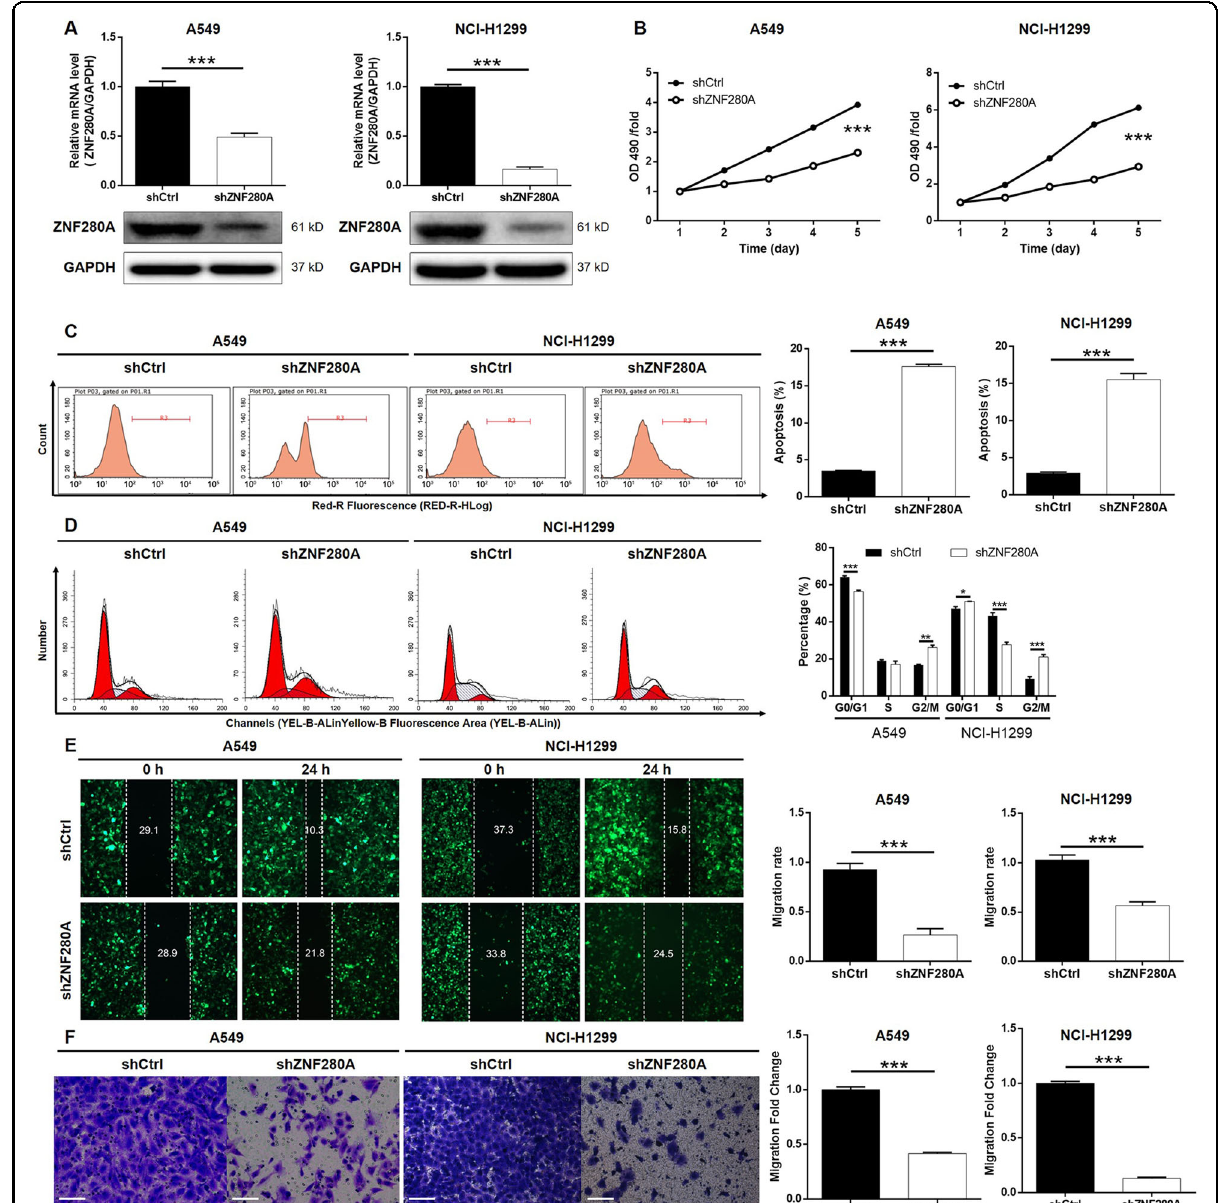
Fig. 2 ZNF280A knockdown inhibited LUAD development in vitro. A , B Cell models with or without ZNF280A knockdown were constructed by infecting shZNF280A or shCtrl. The knockdown ef fi ciency of ZNF280A in A549 and NCI-H1299 cells was assessed by qPCR and western blotting, respectively. B MTT assay was employed to show the effects of ZNF280A on cell proliferation of A549 and NCI-H1299 cells. C Flow cytometry was performed to detect cell apoptosis of A549 and NCI-H1299 cells with or without ZNF280A knockdown. D Cell cycle distribution was estimated in A549 and NCI-H1299 cells with or without ZNF280A knockdown. E , F The effects of ZNF280A on cell migration ability of A549 and NCI-H1299 cells were evaluated by wound-healing assay E and Transwell assay (Scale bar = 100 μ m) F . The representative images were selected from at least three independent experiments. Data were shown as mean ± SD. * P < 0.05, ** P < 0.01, *** P <